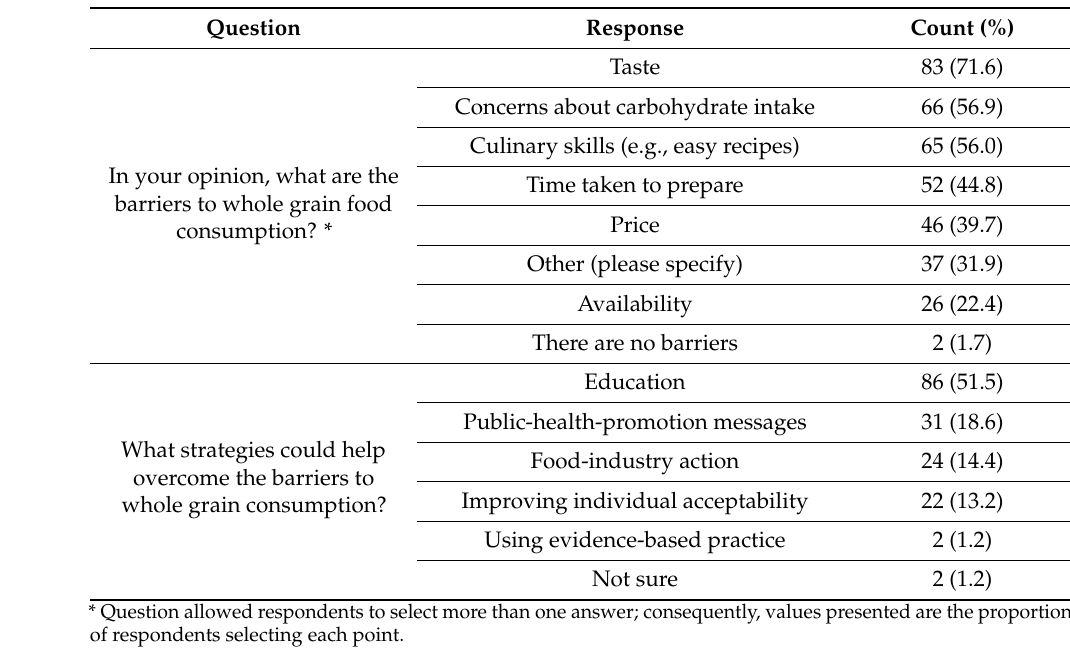
Table 4. Perceived barriers to whole-grain intake, and suggested strategies to overcome them.